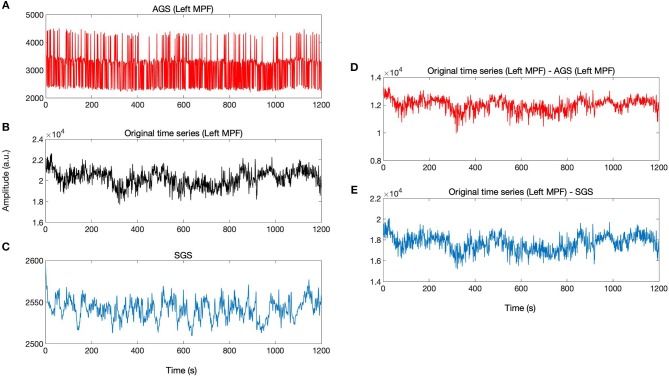
AGSR and SGSR of a sample fMRI data. (A) The voxel-specific AGS of Medial Prefrontal (MPF) cortex region and (B) the original fMRI time series of the peak voxel in MPF cortex region. (C) The SGS which is common for all region's voxels. (D,E) Show the time series with the SGSR and AGSR, respectively. These time series are computed by subtracting the AGS and SGS from the original time series. MPF, Medial Prefrontal cortex; AGS, Adaptive Global Signal; SGS, Static(conventional) Global Signal; AGSR, AGS Regression; SGSR, SGS Regression.